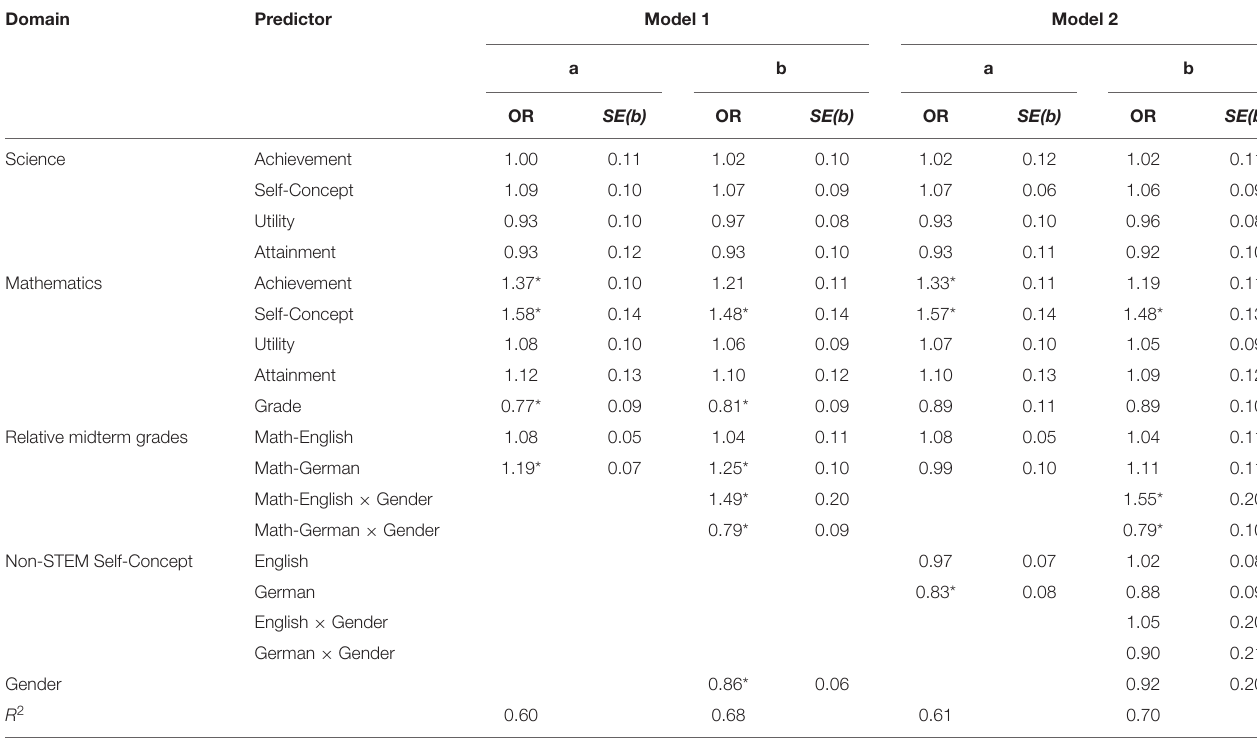
TABLE 3 | Logistic regression for the prediction of science-oriented vs. science-avoidance final exam choices by prior performance, expectancy value variables in mathematics, science, English, and German as well as relative grades (odds ratios). Domain